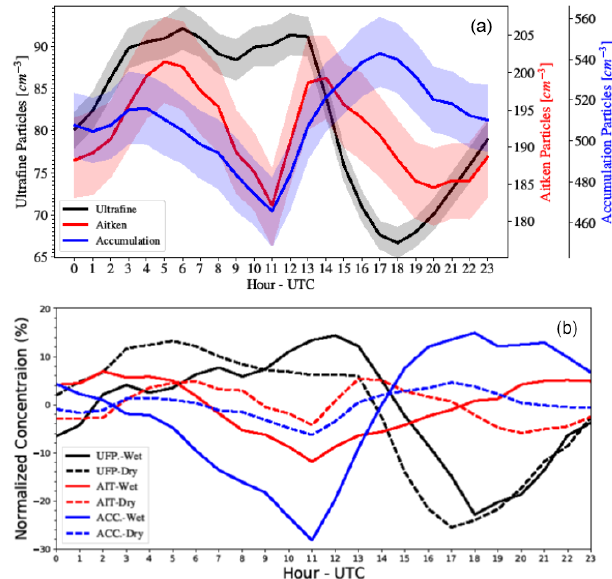
Figure 5. (a) Diurnal cycle of the ultrafine (black), Aitken (red) and accumulation mode particles (blue) at 60m sampling height. The shaded area corresponds to a confidence interval of 95%. (b) Mean deviation of the diurnal cycle of ultrafine, Aitken and accumulation mode particles during dry (dashed line) and wet (solid line) seasons. Time is UTC; LST is UTC −